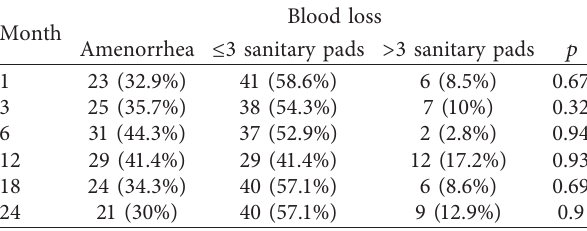
Table 4: Characteristics of blood loss in one-rod users. Blood loss